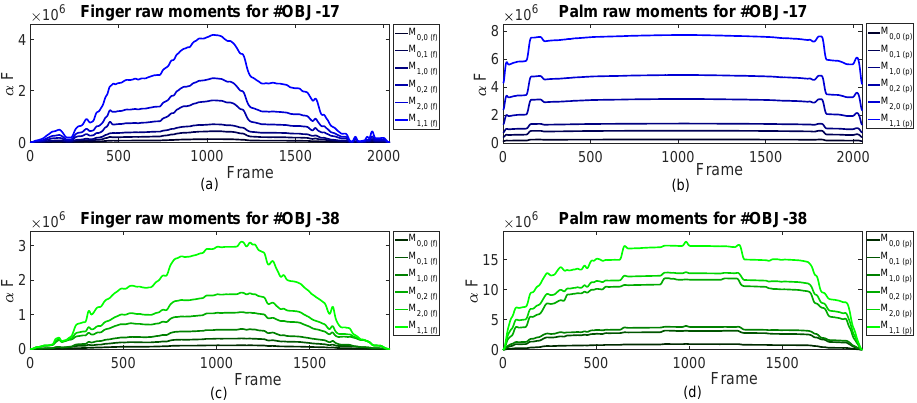
Figure 6. Curves obtained for the first six raw moments ( M p , q ) obtained with the finger ( a , c ), and palm ( b , d ) from the exploration of the #OBJ-17 and #OBJ-38